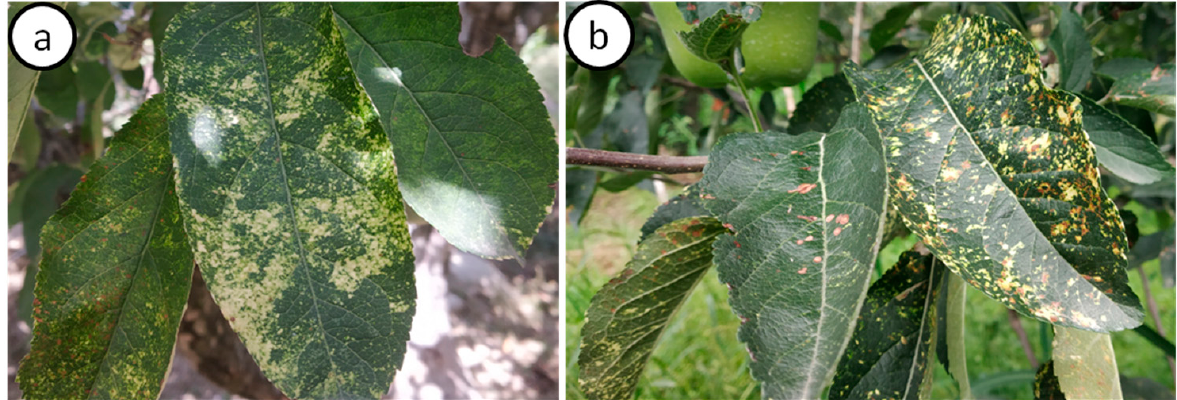
Figure 2. The symptoms of mosaic and necrotic mosaic on two cultivars: Golden Delicious ( a ) and Oregon Spur ( b ).